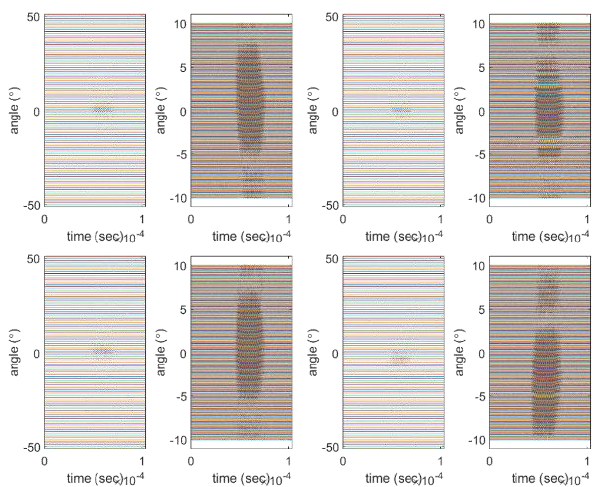
Figure 9. Example of filtered data: ( a ) ex 1; ( b ) zoomed ex 1; ( c ) ex 2; ( d ) zoomed ex 2; ( e ) ex 3; ( f ) zoomed ex 3; ( g ) ex 4; ( h ) zoomed ex 4.